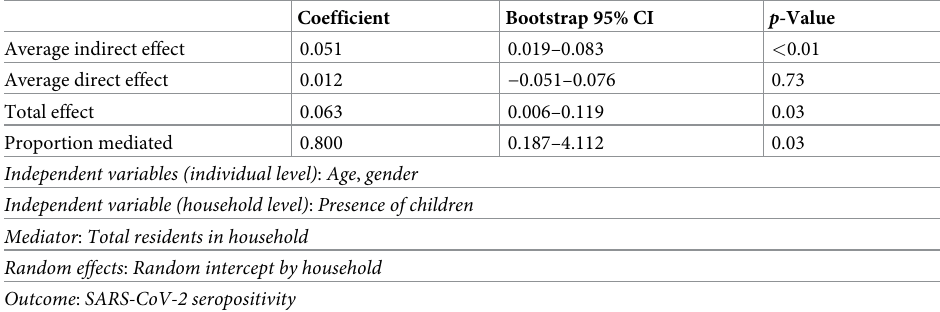
Table 3. Mediation analysis for the effect of presence of children in the